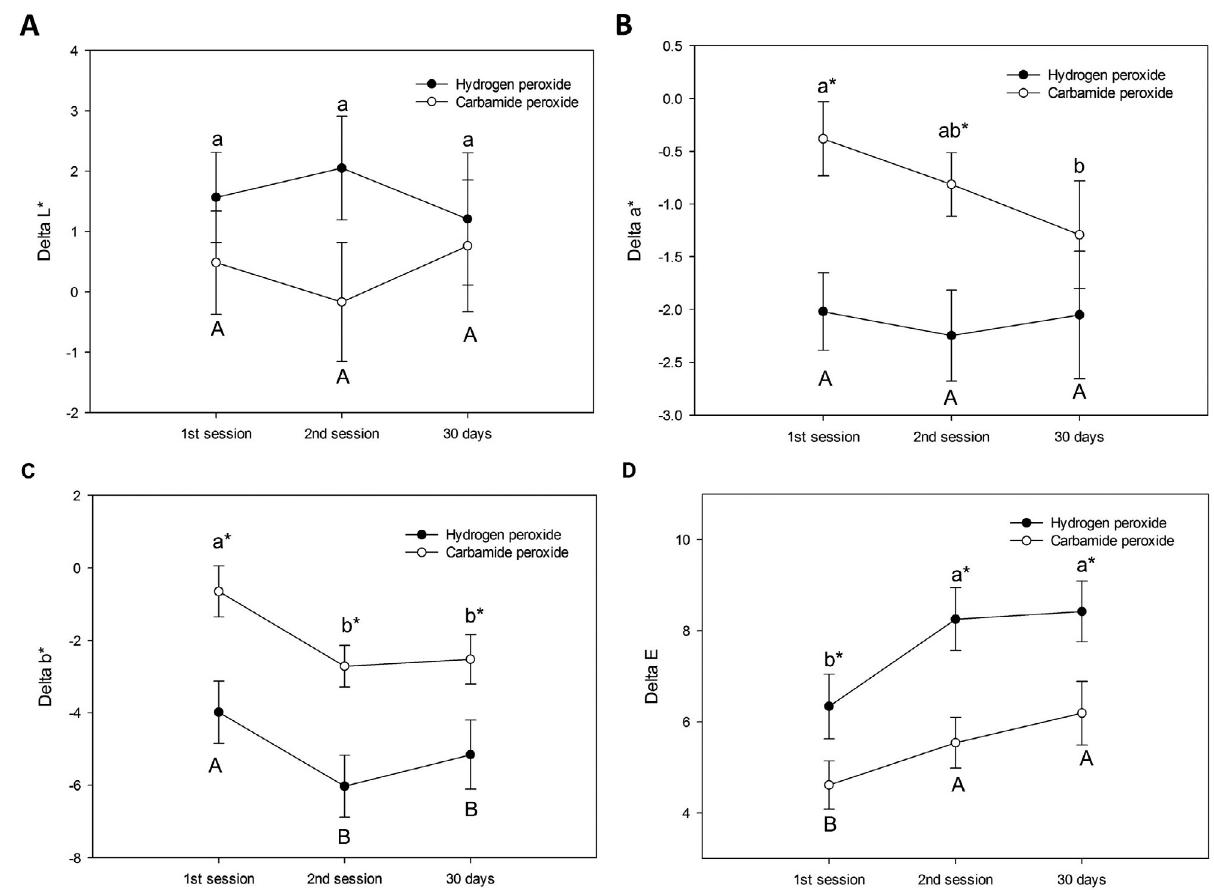
Figure 2- Results of the color evaluation regarding ∆L* (A), ∆a* (B), ∆b* (C) and ∆E (D). Distinct letters (lowercase for hydrogen peroxide; uppercase for carbamide peroxide) indicate significant differences between the assessment times for each bleaching agent (p<0.05). * Indicates a significant difference between the bleaching agents at each assessment time